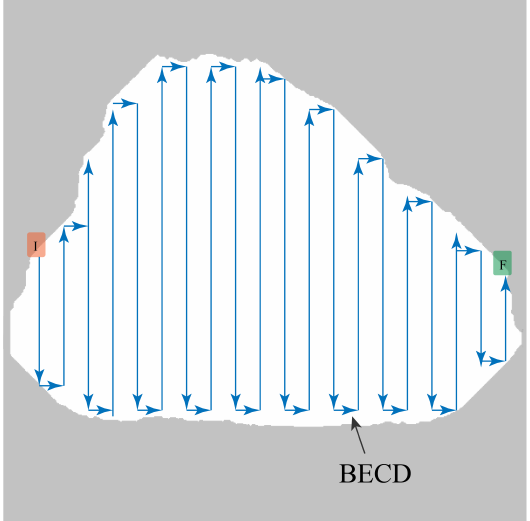
Figure 2. The RoI and the path generated from the initial point (I) to the final point (F) by